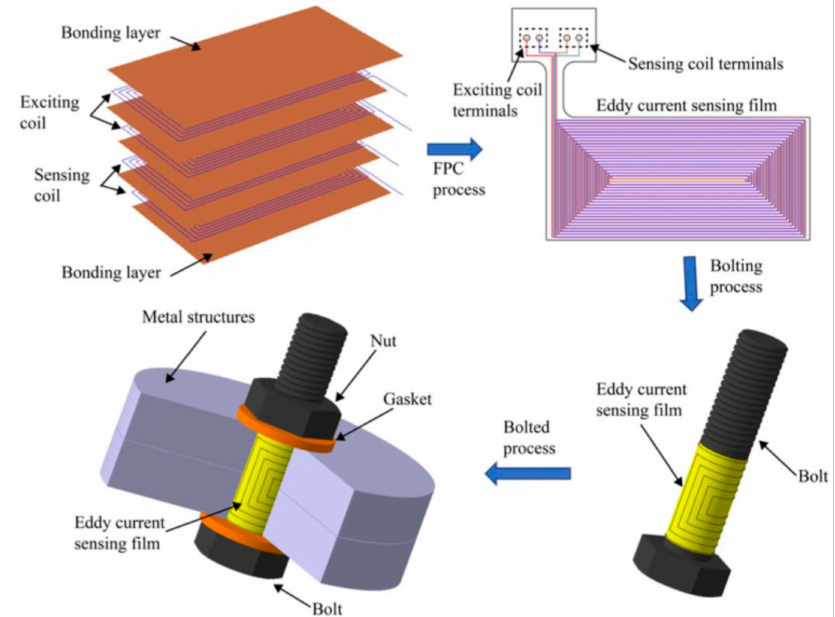
Figure 1. An eddy current (EC) sensing film-based intelligent bolt.